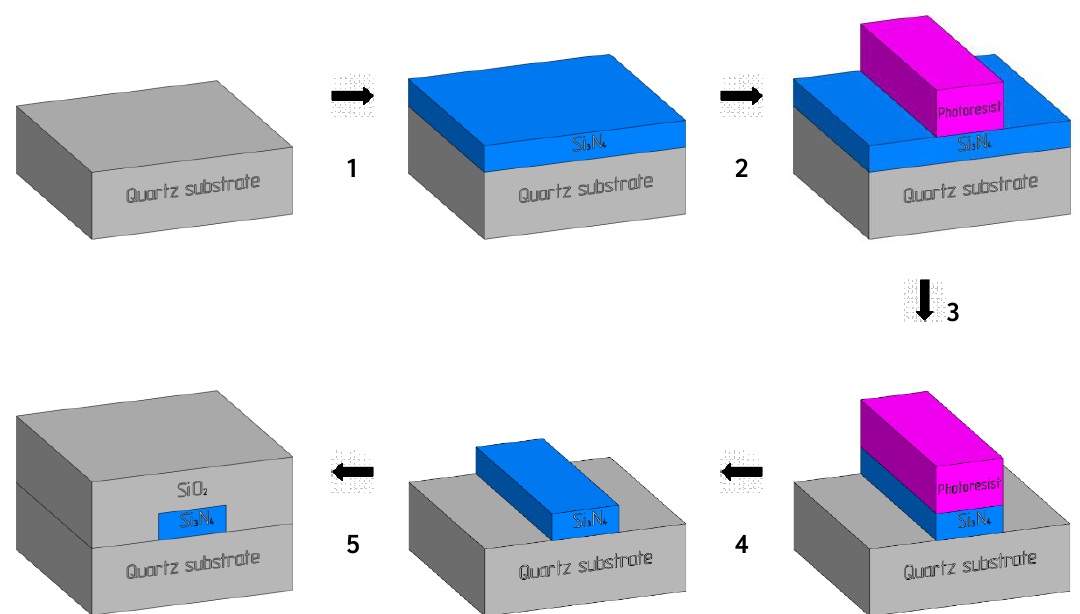
Figure 1. The fabrication steps for the integration waveguide with core Si 3 N 4 based quartz substrate: 1—core deposition Si 3 N 4 (LPCVD, 790 ◦ C); 2—spin photoresist, UV exposure and developed; 3—plasma etch (core etch) Si 3 N 4 ; 4—remove photoresist; 5—upper cladding deposition using TEOS (tetraethyl orthosilicate)-based PECVD (plasma enhanced chemical vapor